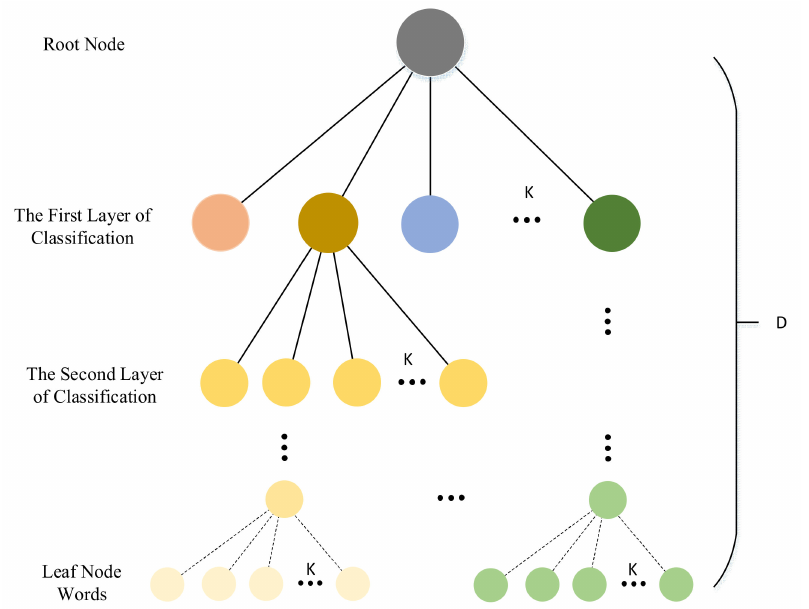
Figure 4. This is the structure of the k-ary tree of BoW. Different colors represent different clusters. The cluster number of each node is k, and d denotes the depth of the